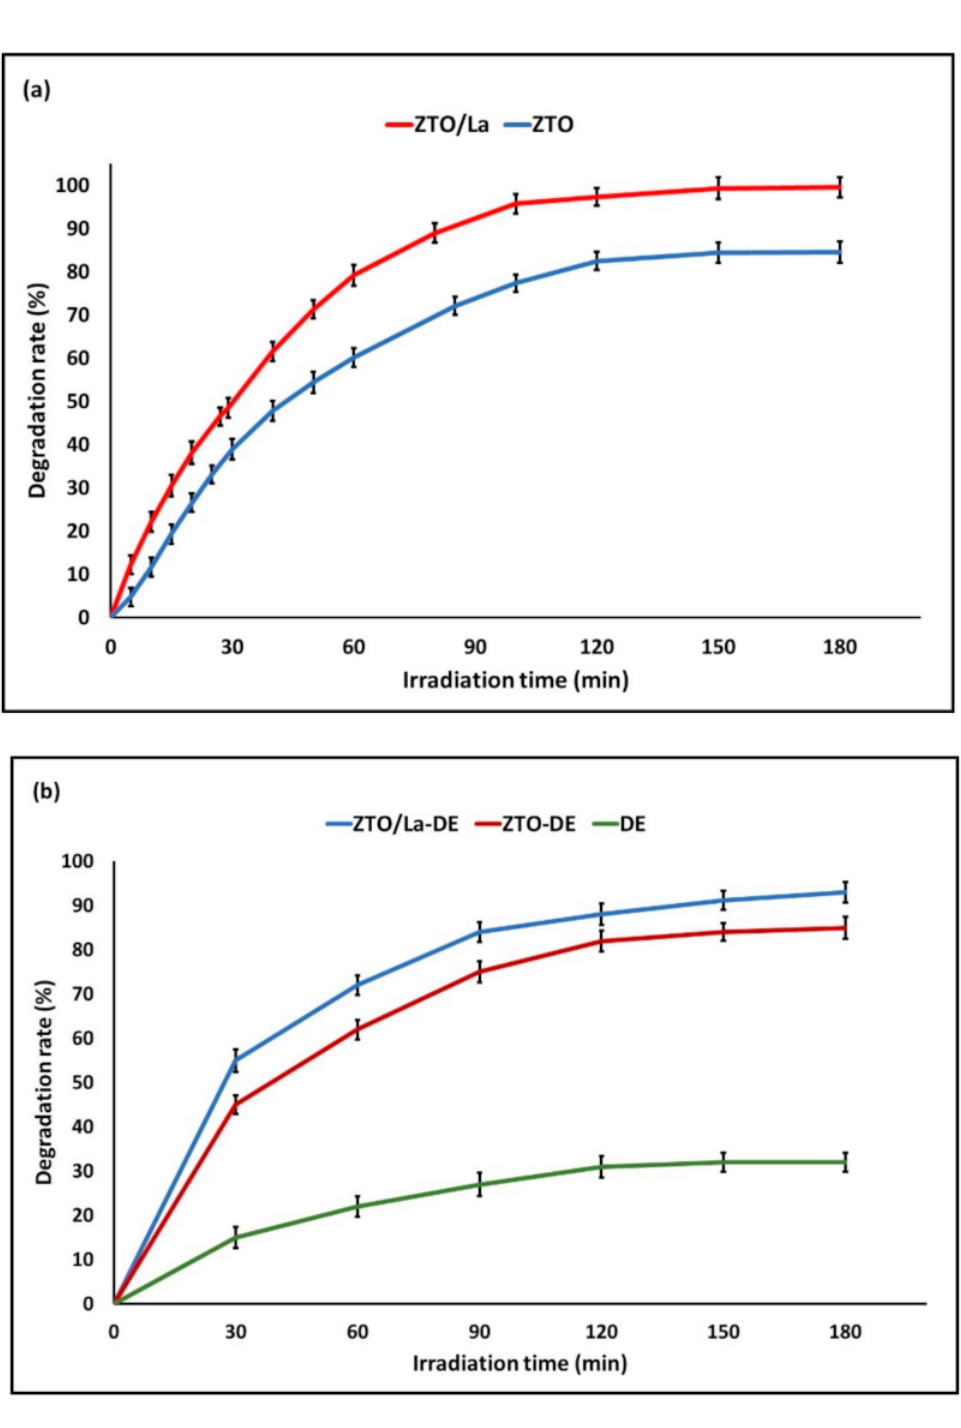
Figure 10. Photocatalytic degradation of MB by ( a ) a photocatalyst and ( b ) a supported